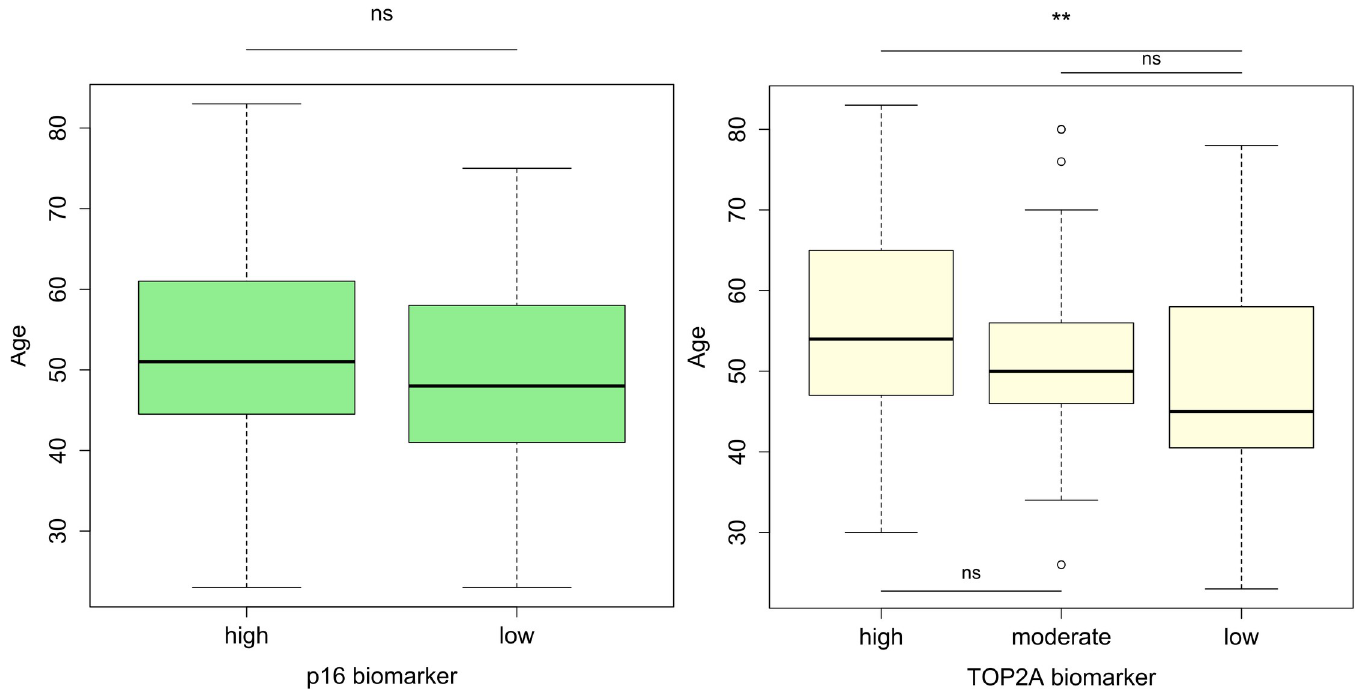
Fig 2. Distribution of p16 and TOP2A biomarkers expression across age-groups among women seeking care at Kilimanjaro Christian Medical Centre (n = 145). The bold horizontal line within each column represents medians. Statistical significance is marked with double asterisks (Student’s t -test, p = 0.006) and ns stands for not significant.